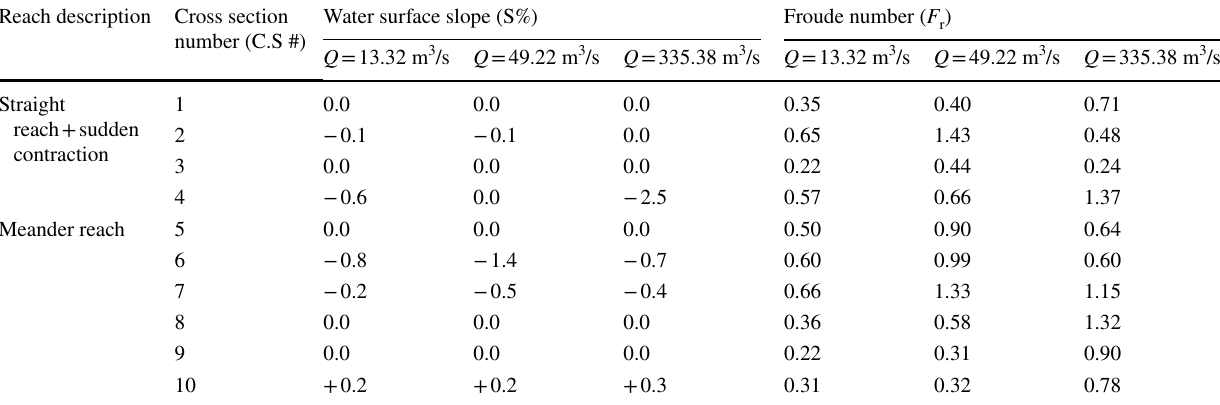
Negative slope means the water surface increase toward the left bank, and for positive slope its